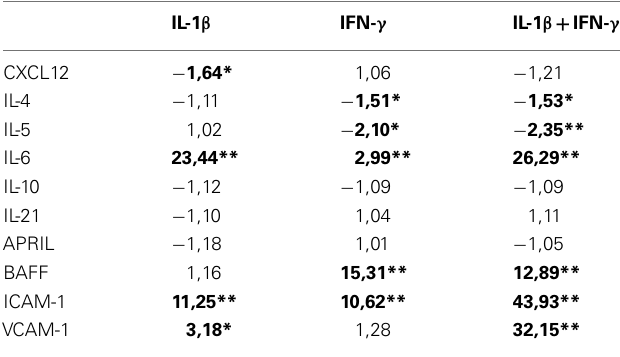
Table 1 | Gene expression of factors relevant to plasma cell survival which are produced from stromal cells exposed to IL-1 β and IFN- γ